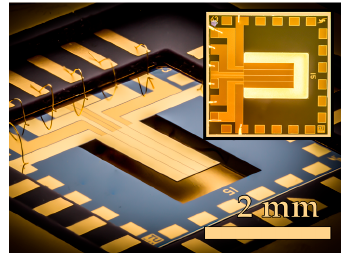
Figure 1 . Optical micrograph of the in-house fabricated silicon die (6 mm × 6 mm), containing one piezoelectric actuated plate (dimensions: 2524 µ m × 1274 µ m × 20 µ m) using advanced electrode